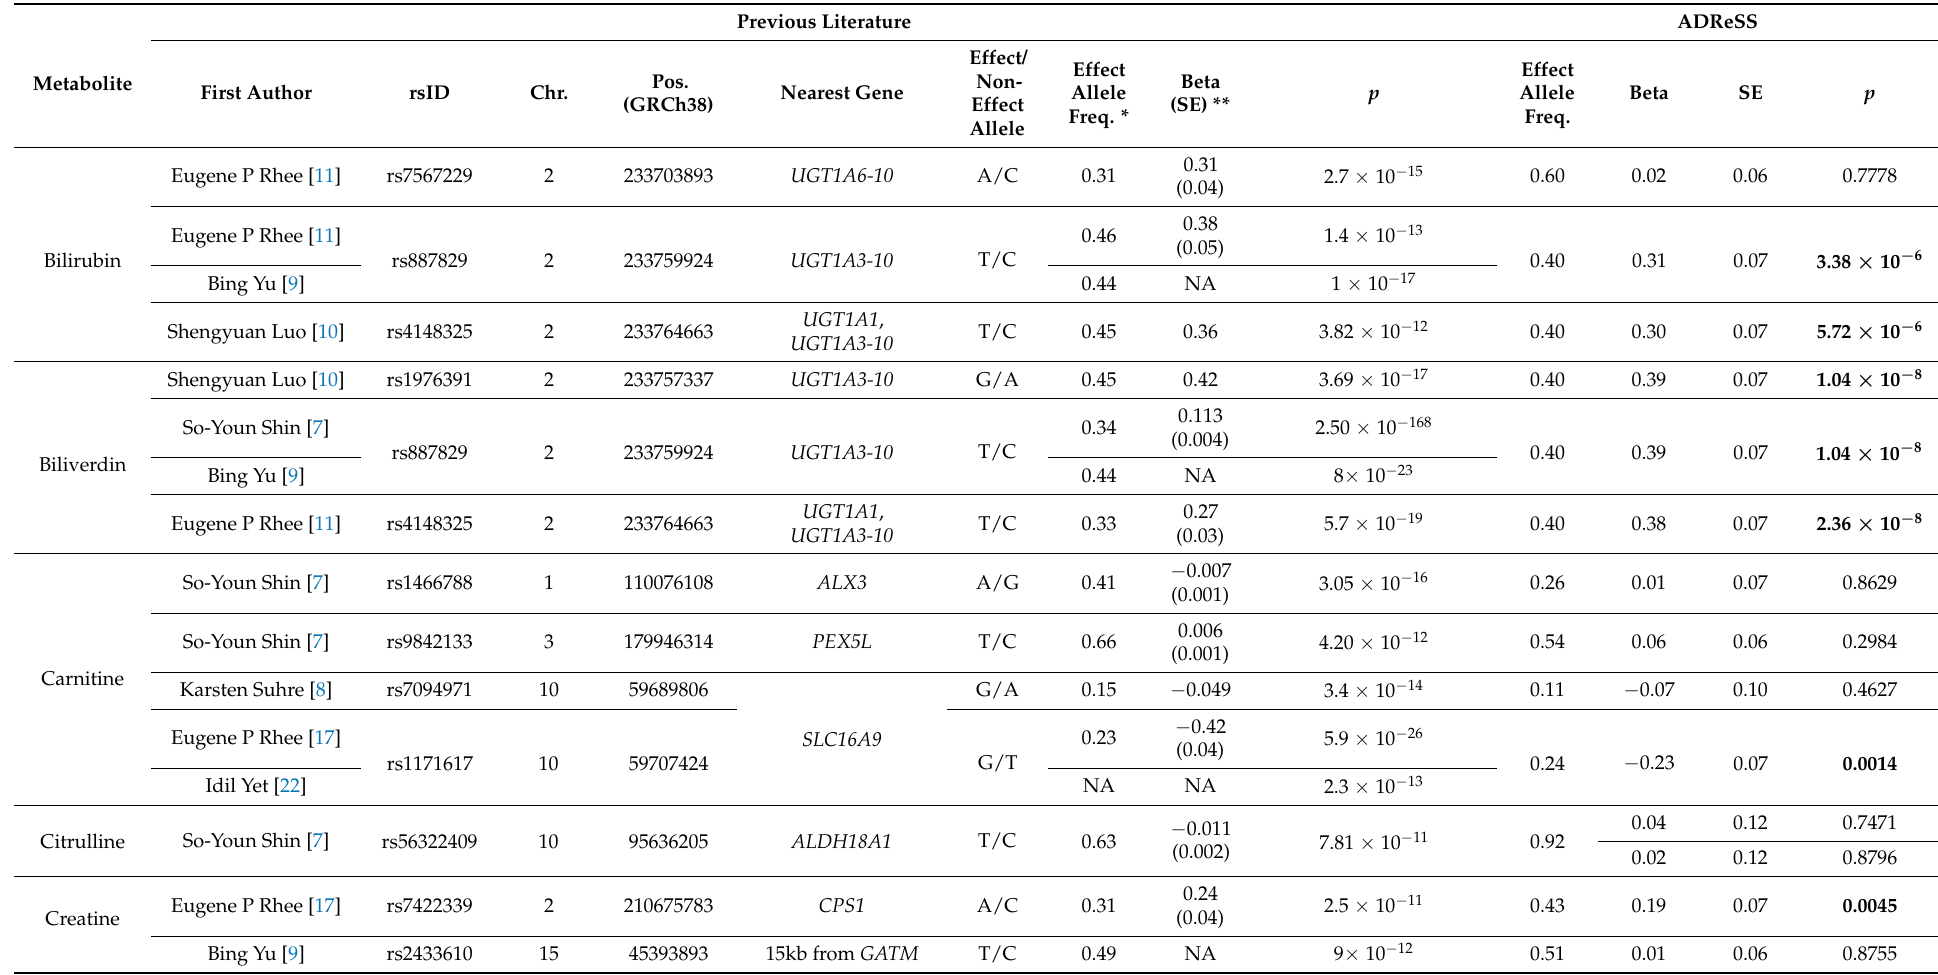
Table 3. Previously reported genetic associations with